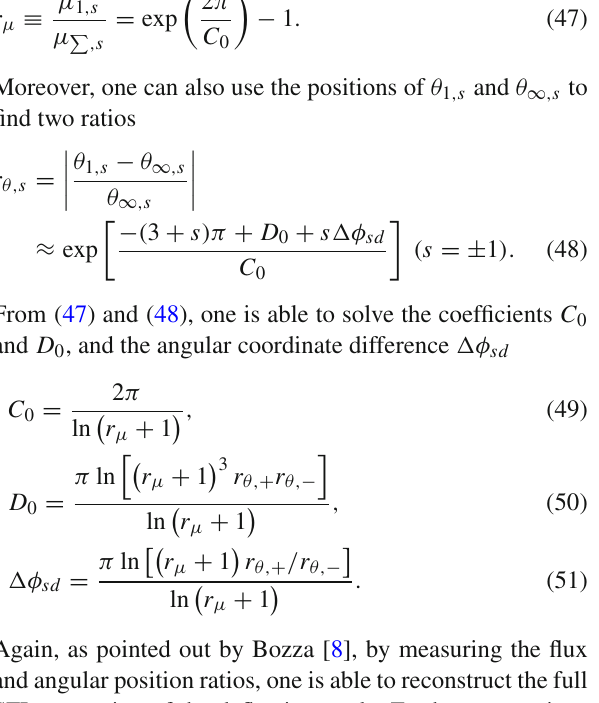
Fig. 2 The critical radius r c (red) and impact parameter b c (blue) as functions of l for the Hayward BH spacetime for v = 1 (solid) and v = 0 . 9 (dashed)